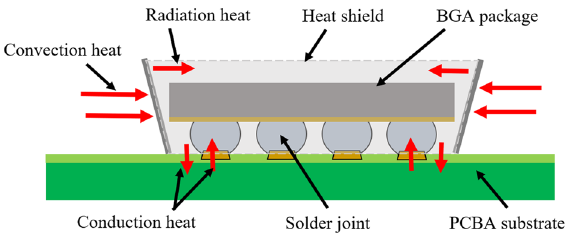
Figure 5. Schematic of the combination of convection, radiation, and conduction heat interactions on the BGA component solder joints in sample X during rework.